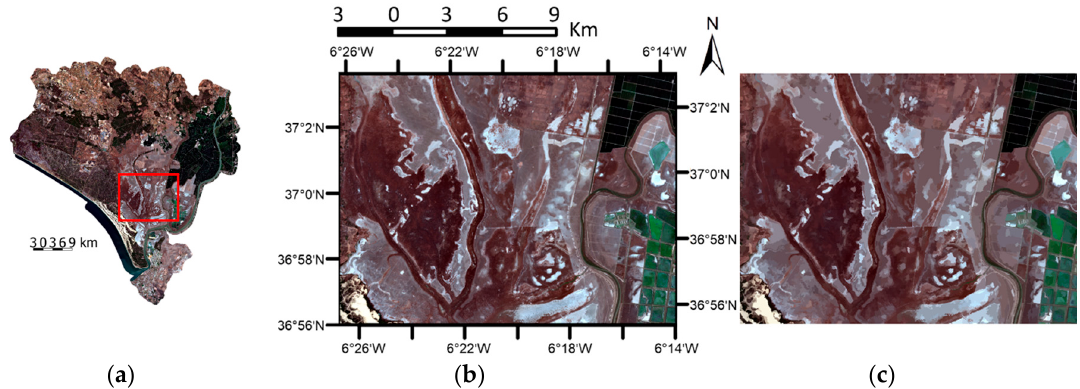
3. Figure 3. ( a ) RGB S2 satellite image on 20 August 2017 with a subset enclosed in the red square region, ( b ) the zoomed subset of the RGB image and ( c ) its mean-shift segmentation map. The coordinate grid of the middle and right subsets is the same; thus, it is drawn only around the middle